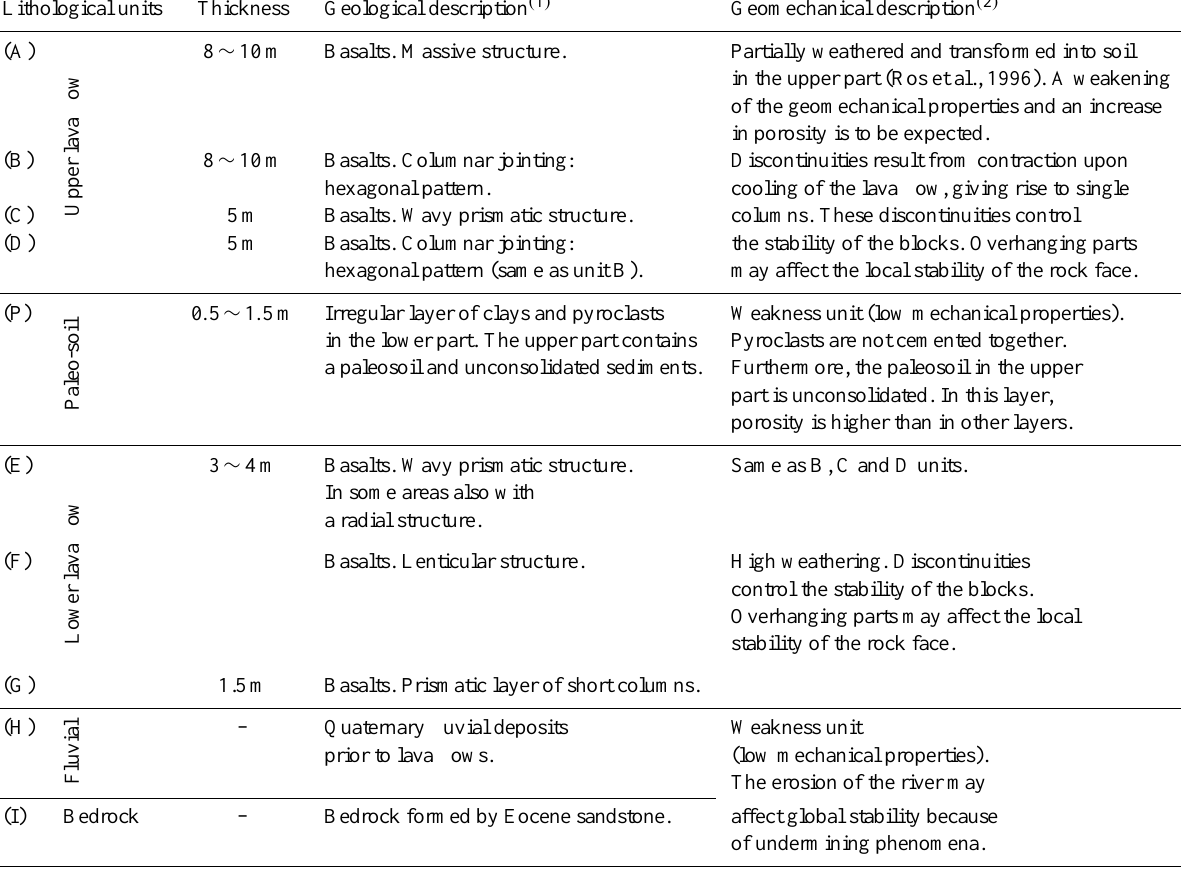
Table 1. Main geological and geomechanical characteristics of the stratigraphic sequence. Lithological units Thickness Geological description ( 1 ) Geomechanical description ( 2 )